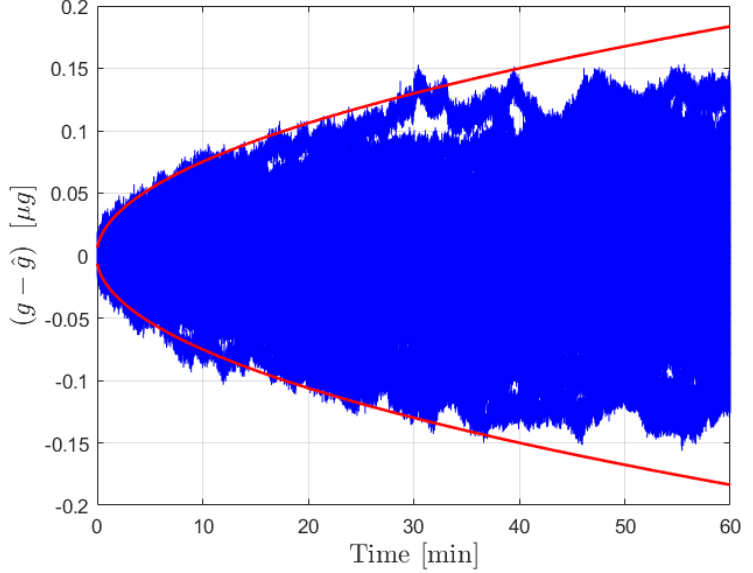
Figure 5. Results for the forcing acceleration estimate error from the moving least squares procedure for 100 Monte Carlo iterations. Estimate error is plotted in blue with the associated 3 σ bounds in